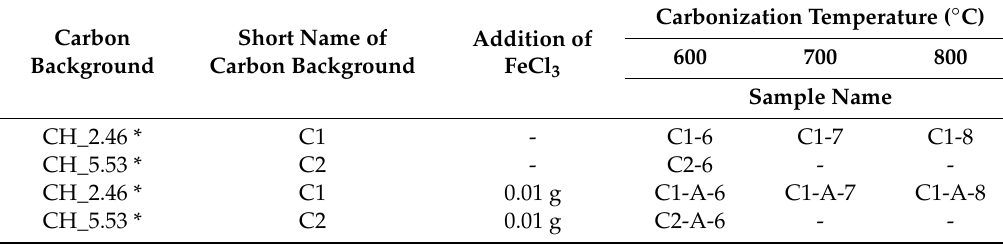
Table 1. Summary of experimental procedure for sample